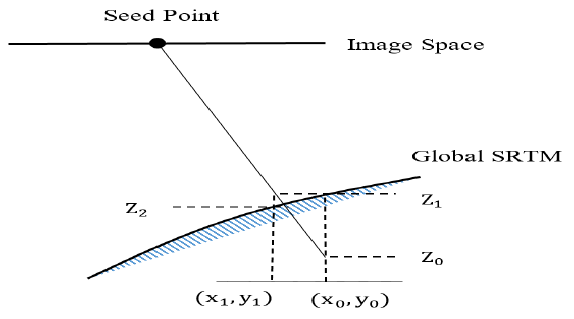
Figure 4. The principle of the iterative elevation determination.